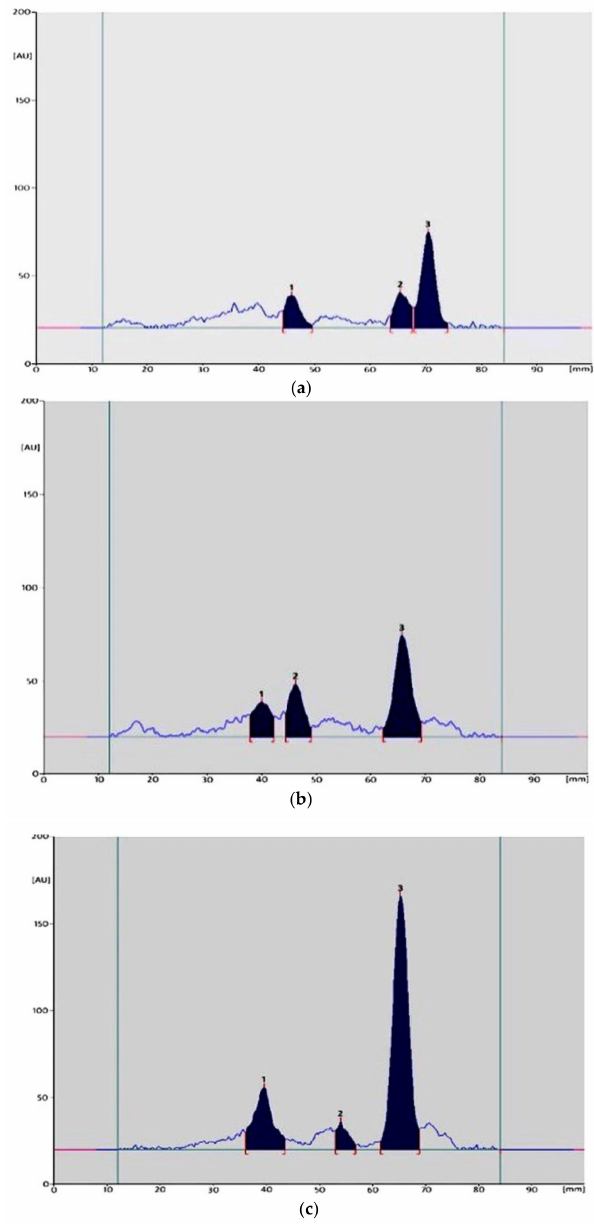
Figure 4. An example of densitograms obtained for MTZ standard substance ( a ), tablets ( b ), and